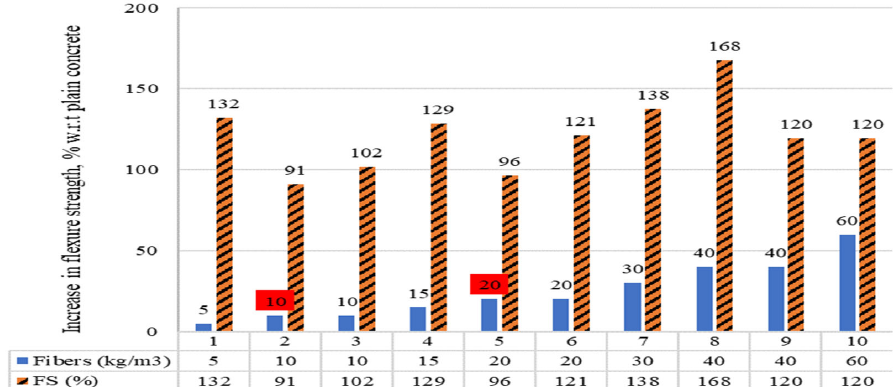
Figure 15. Percentage comparison of flexure strength of concrete containing RSF in kg/m 3.